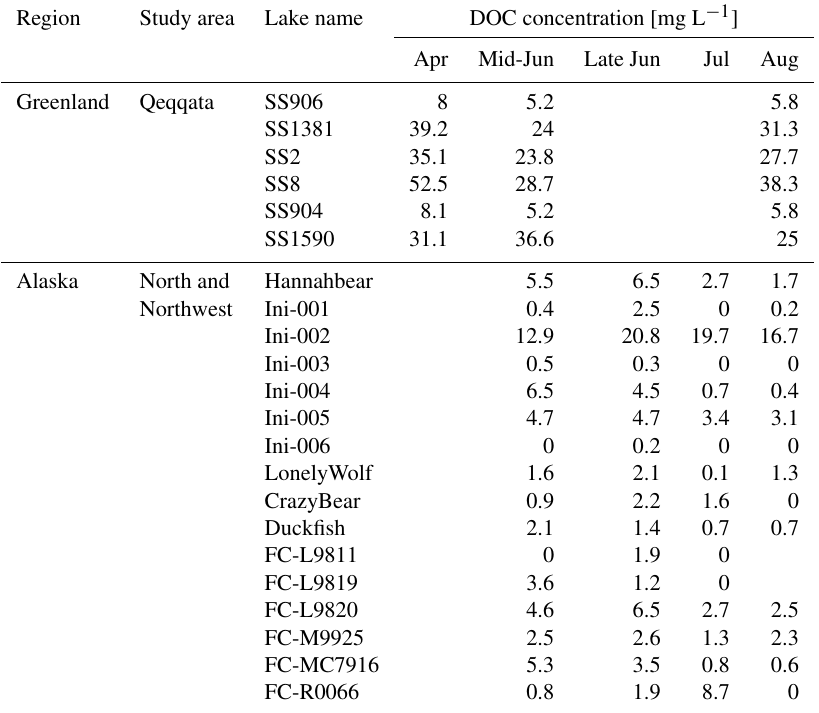
Table 2. DOC concentration of six lakes from Qeqqata, Greenland, sampled three times in 2014 (Osburn et al., 2017) and 16 lakes from North Slope, Alaska, samples four times in